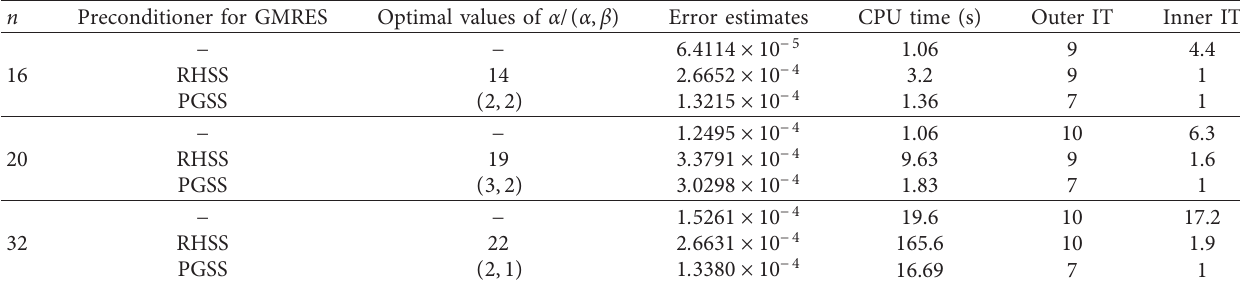
Table 8: Numerical results of preconditioned inexact Newton methods for v � 0.1 and η � 0.2. n Preconditioner for GMRES